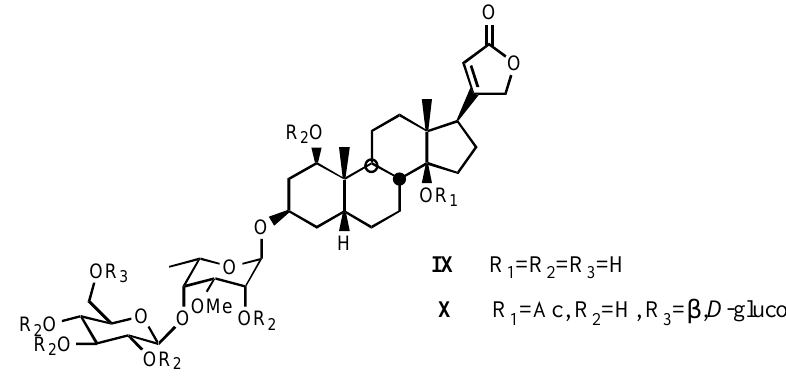
Figure 5. Structure of acobioside A ( IX ) and 14- O -acetylacovenioside C ( X ).